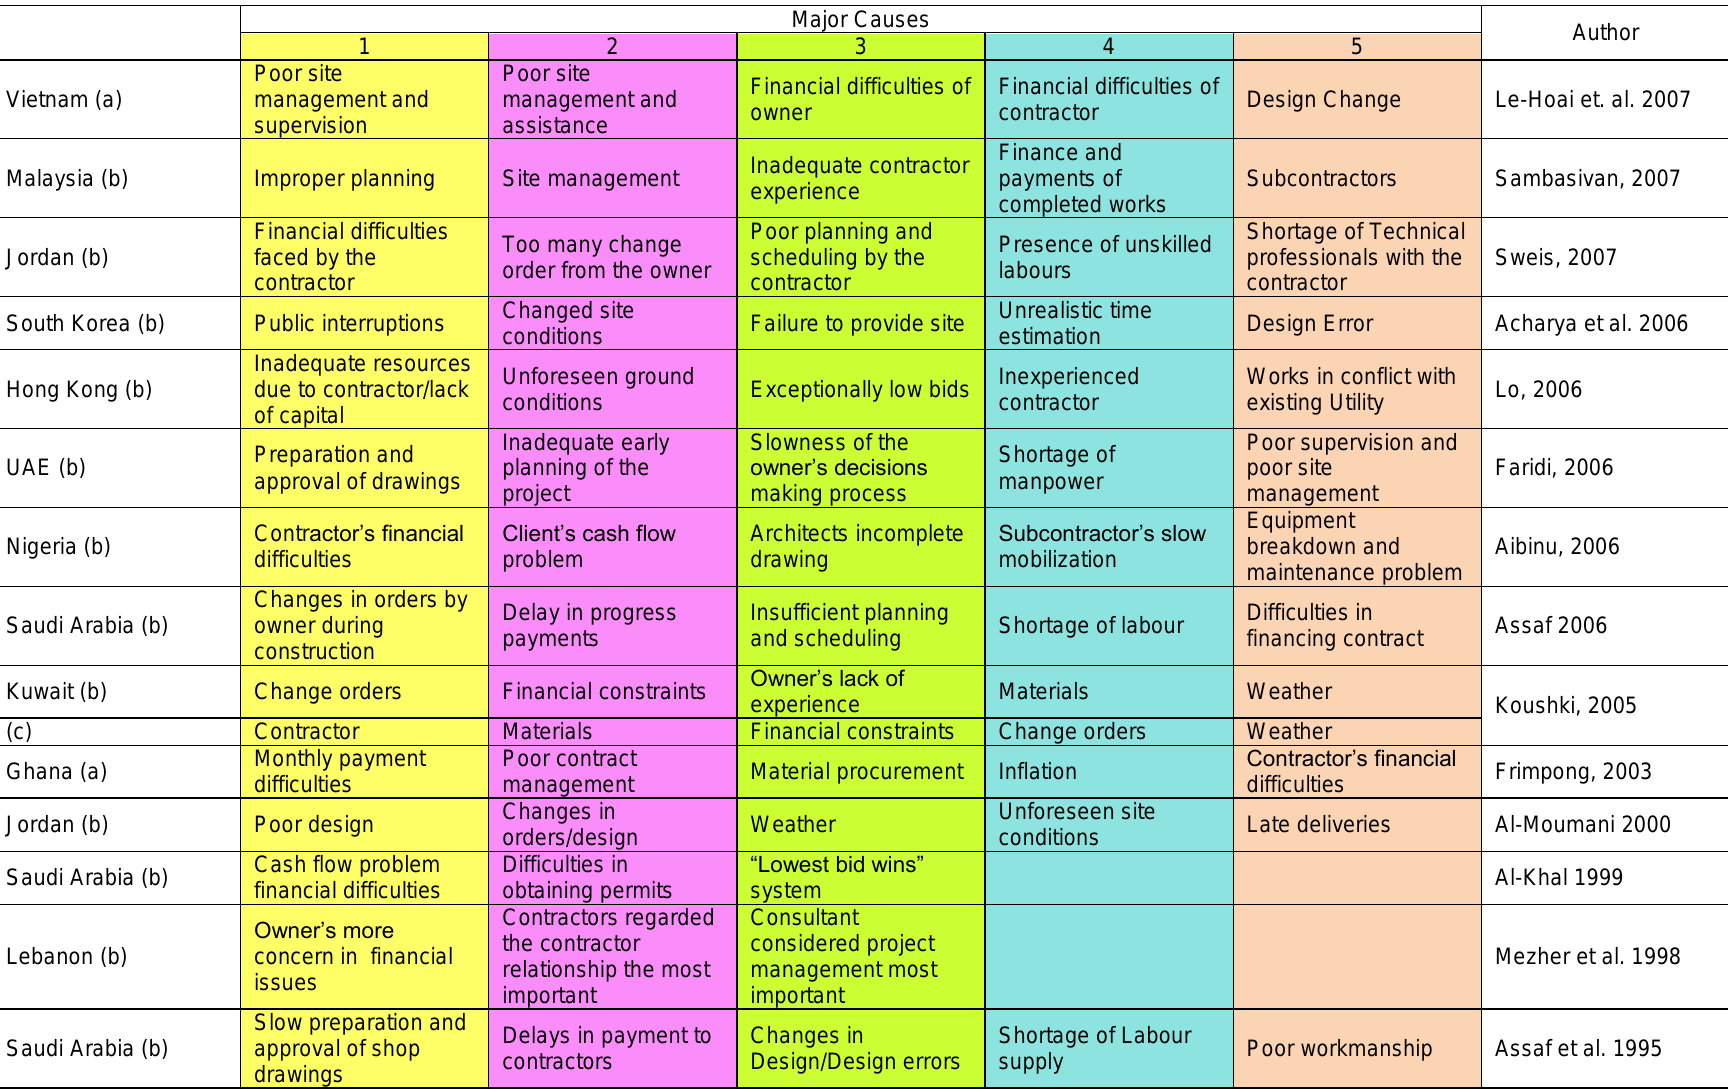
Table 7 Comparison of previous studies on delay and cost overrun in construction projects in different